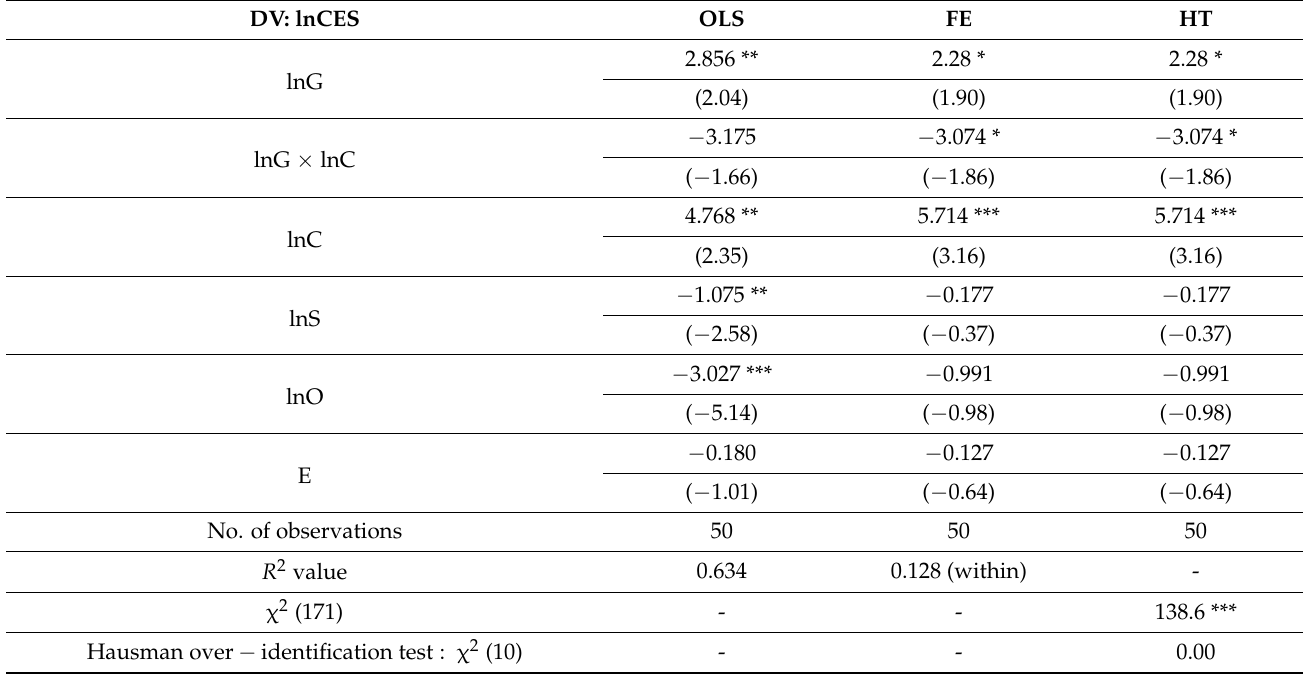
Table 6. Regression results for the robustness tests.